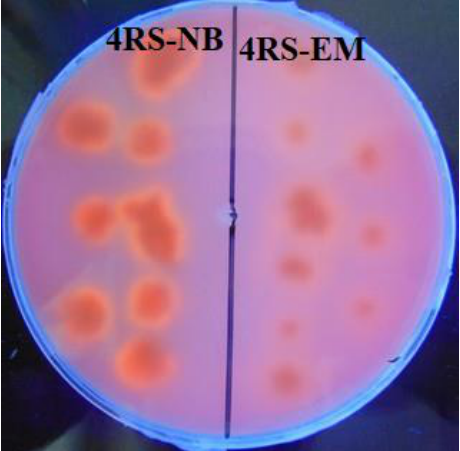
Figure 4. Lipolytic activity on rhodamine B leading to the formation on a fluorescent halo. 4RS-NB and 4RS-EM—four reseeding of microorganisms cultivated in NB and EM, respectively.